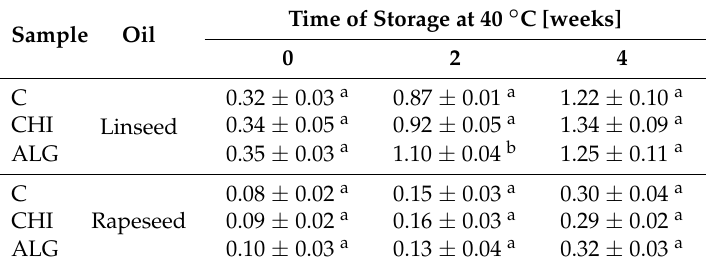
Values in individual lines marked with the same letters do not differ significantly ( p < 0.05, n =